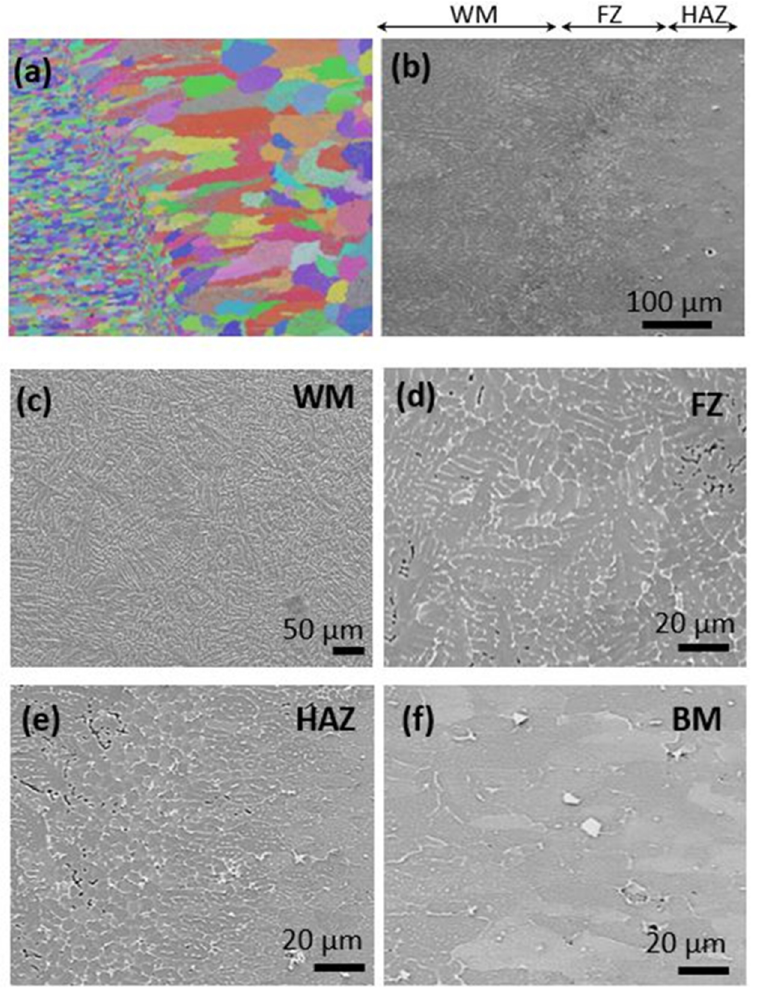
Figure 16. ( a ) EBSD, and ( b ) SEM images of weld zone of the standard sample, and enlarge SEM images of ( c ) WM, ( d ) FZ, ( e ) HAZ, and ( f ) BM regions.